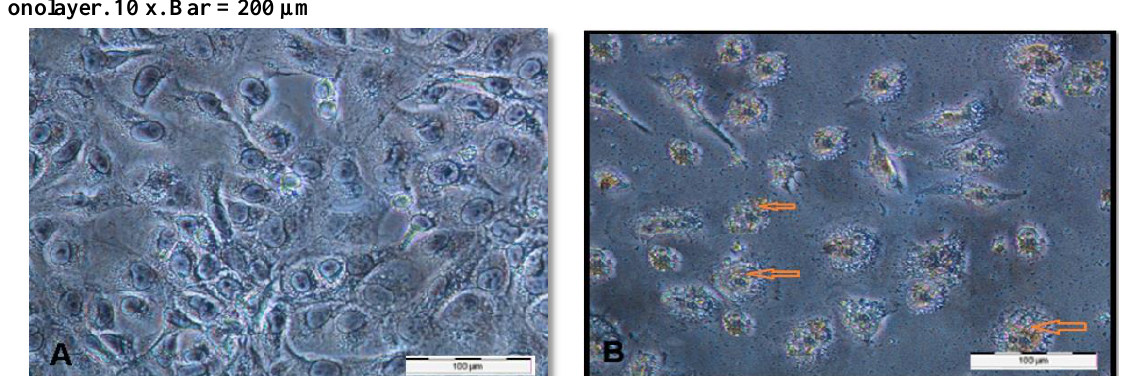
Figure, 2: Identification of IBV in CAM cells culture using infected cell cultures stained with HRP-conjugated antibody. (A) Uninfected control CAM cells. (B) CAM cells infected with IBV at 3 rd passage at day 5 pi. The arrow shows the presence of specific intracytoplasmic brownish coloration IBV antigens. 10x. Bar = 100